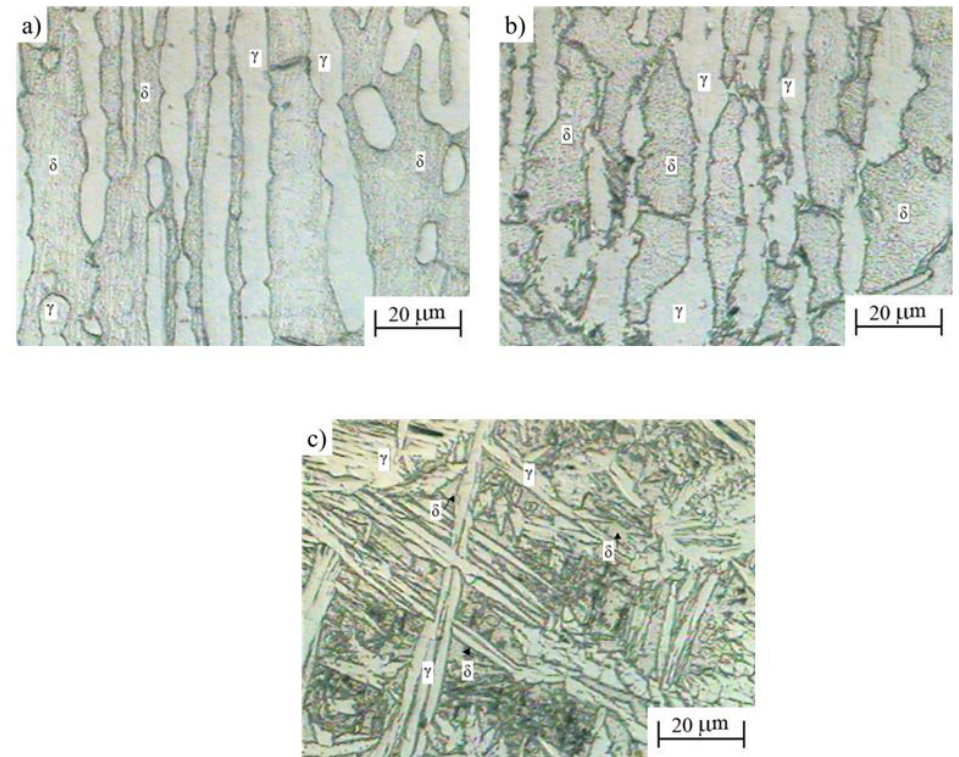
Figure 6. Microstructure of WJ2 treated 60 minutes at 800°C. Images for (a) BM, (b) FL and (c) WMC regions. Reagent: